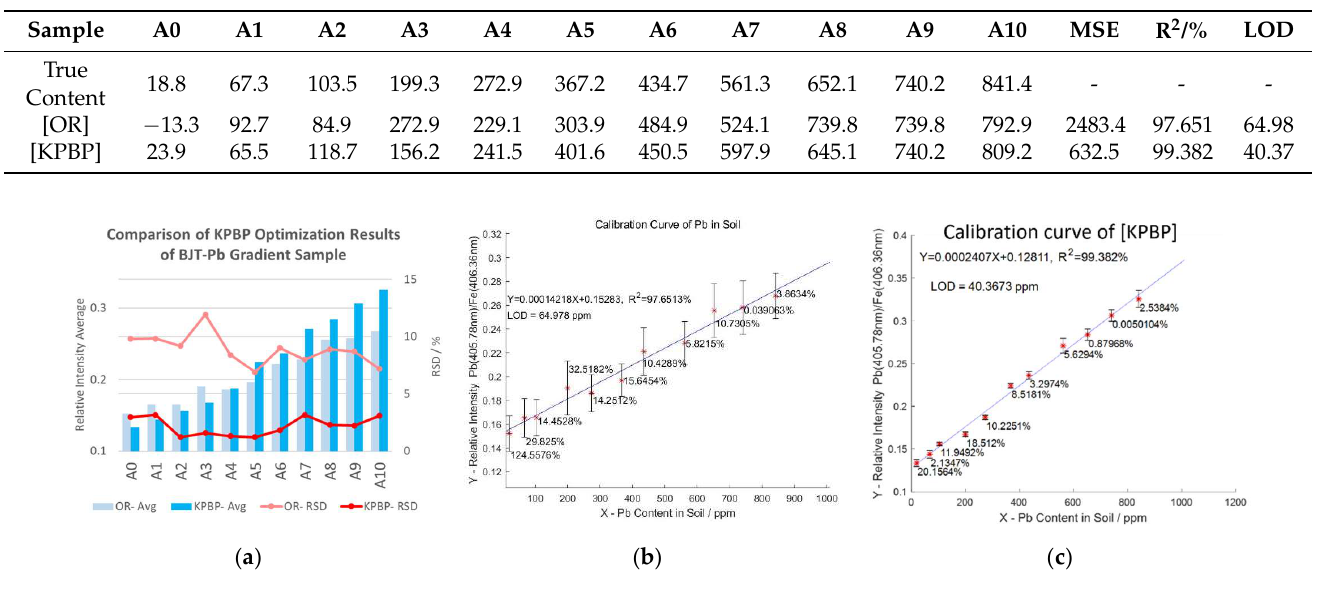
Table 2. The true lead content in each sample and the predicted content in each sample calculated by the leave-one-out method (unit ppm unless noted).